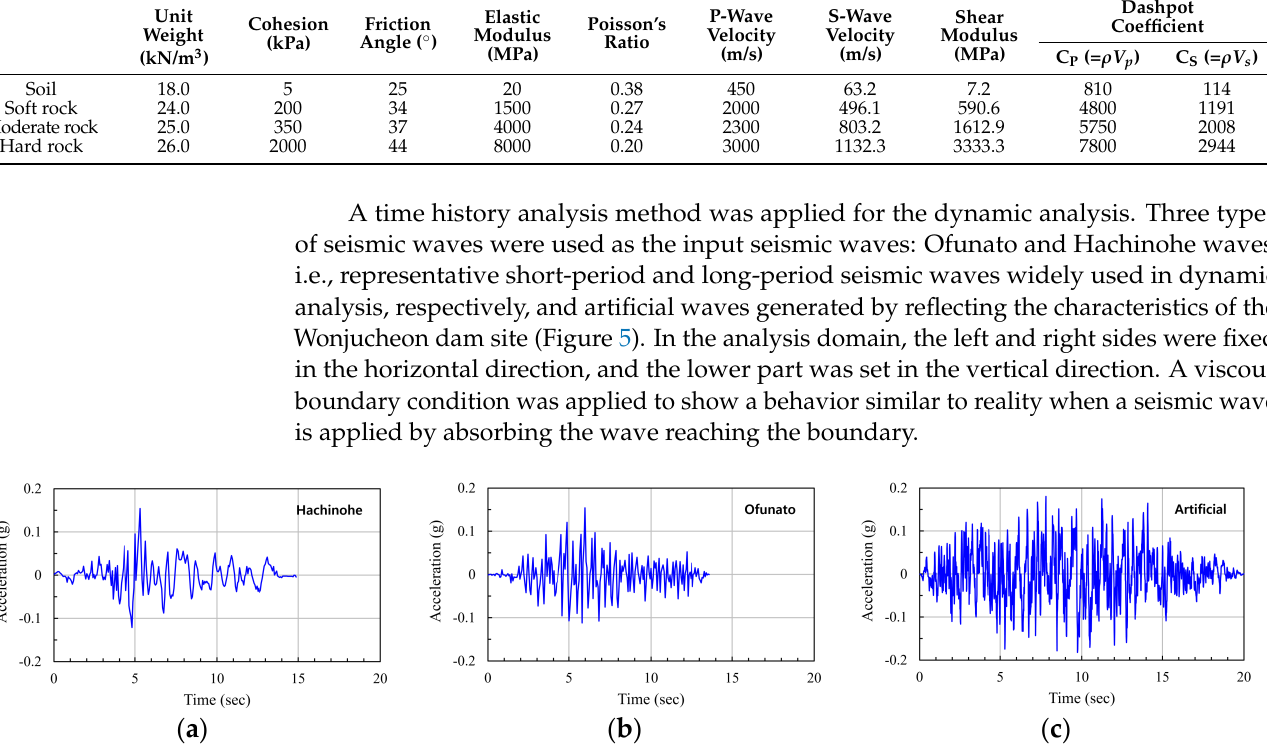
Figure 6. Change in dry unit weight according to hardfill unit water content.